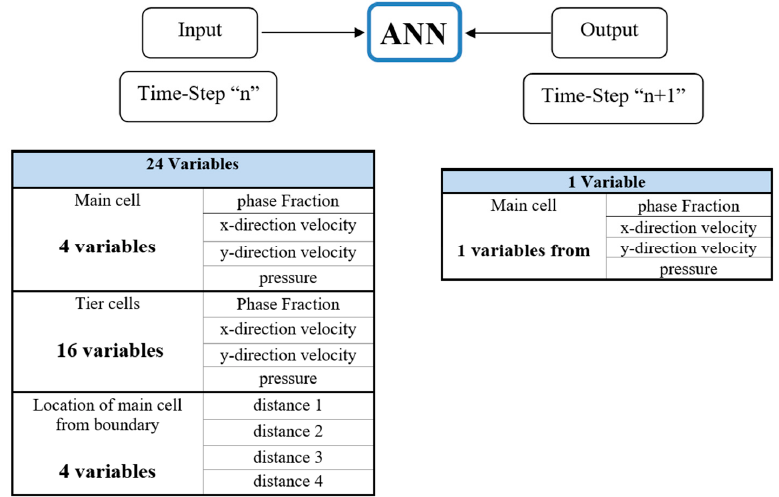
Figure 14. Number of output and input in ANN.